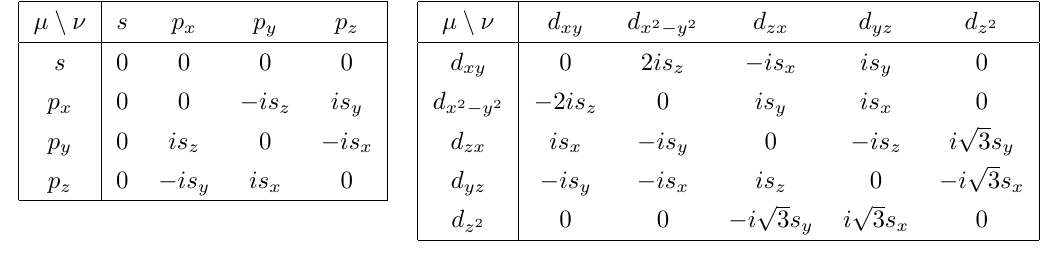
D E ~L · ~S . It is implicitly assumed that the principal µν = σ 2 ( f = x, y, z f f /